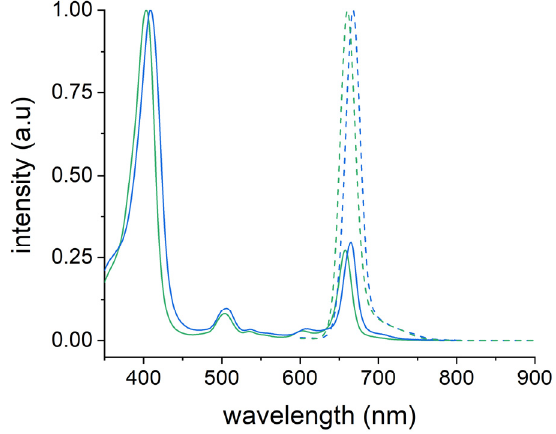
Figure 6. Normalized absorption (full line) and fluorescence (l ex = 500 nm, dashed line) spectra of Ce6 (green lines) and Ce6@HSA (blue lines) in PBS at room temperature.